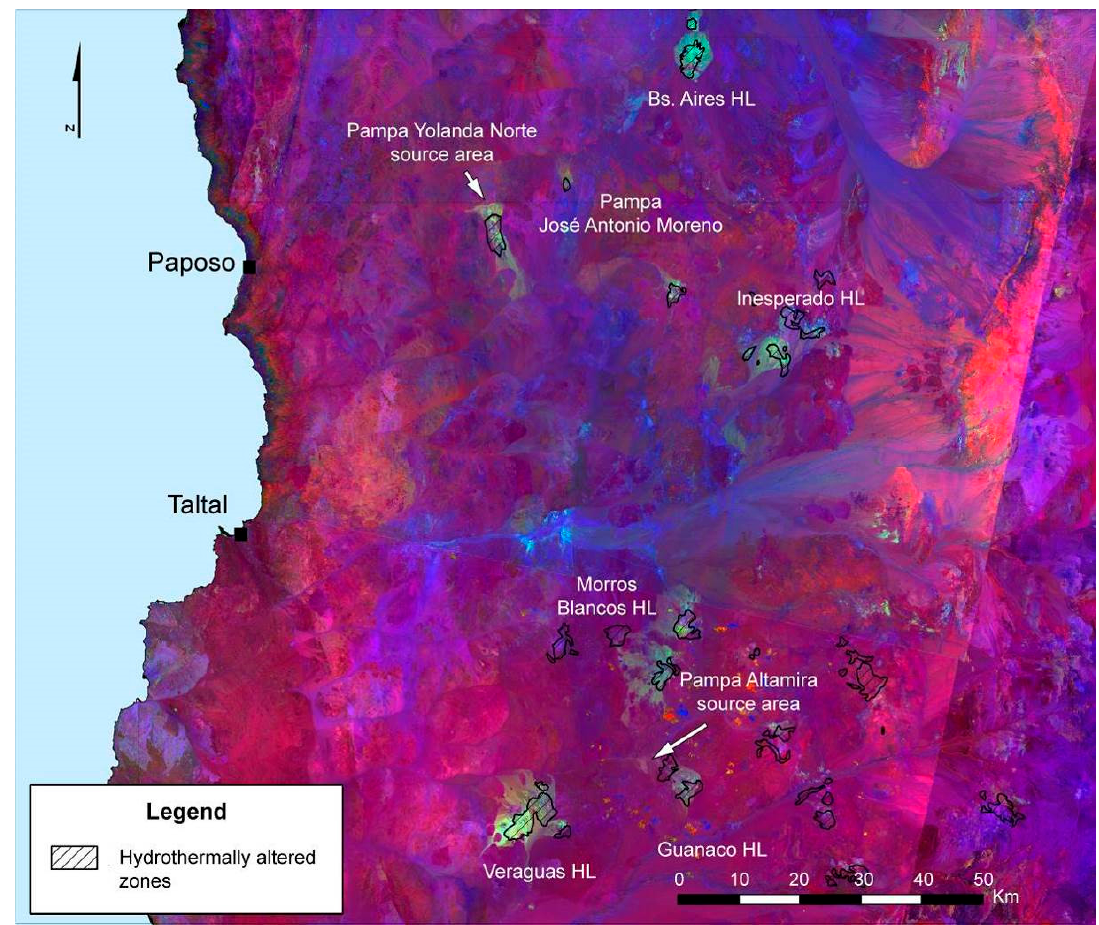
Figure 5. Landsat 8, band ratio 4/2-6/7-5 (RGB) false-color composite. Potential and actual chert source areas are highlighted in light green, and hydrothermally-altered zones are shown as black hatched polygons.